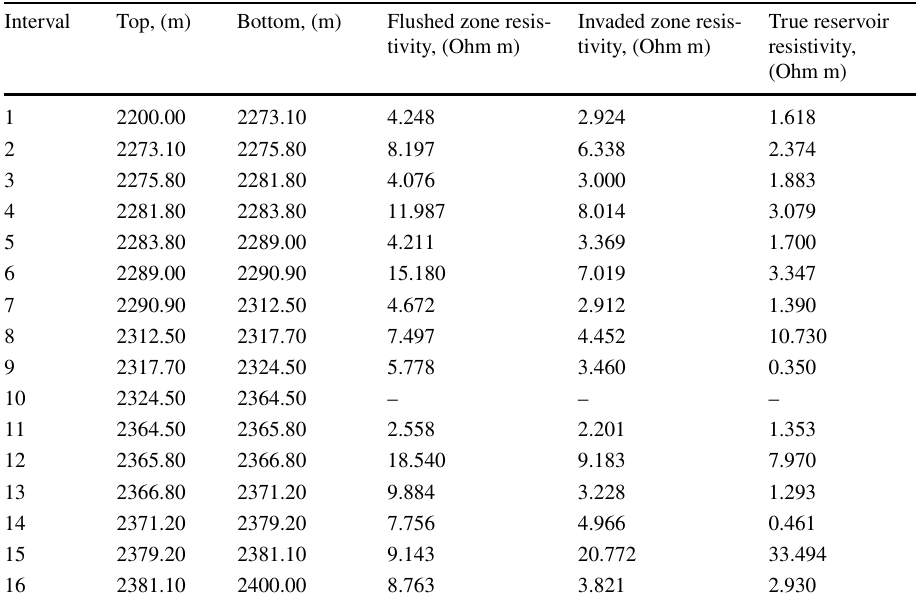
of array lateral logging for Paleocene deposits of Well # 7